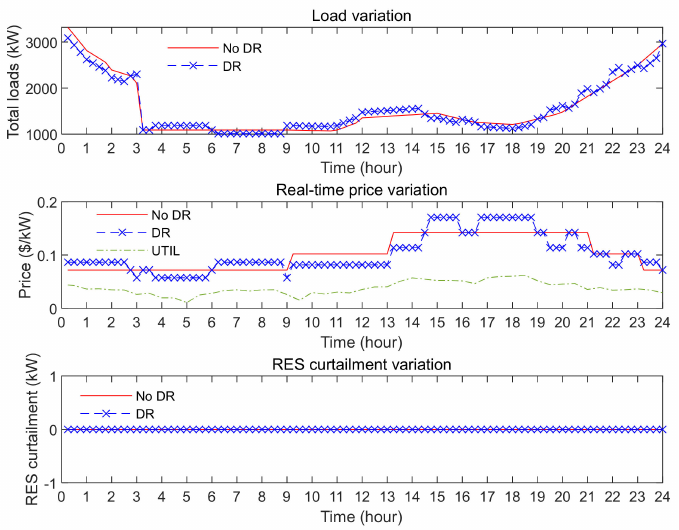
Figure 11. Variations of load demand, real-time prices, and RES curtailment for load type B (the distribution operator is able to sell electricity to the utility